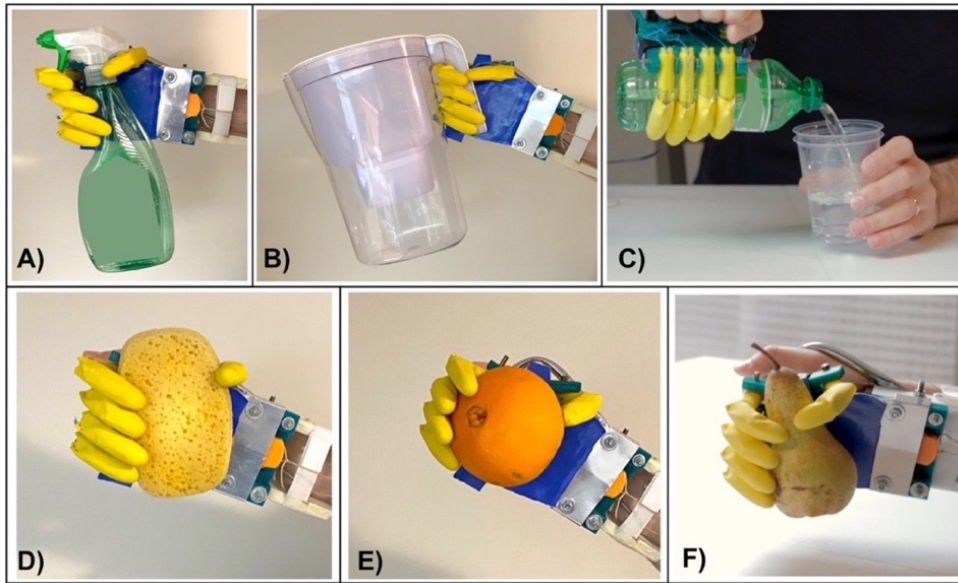
Figure 14. “Federica” hand tested on healthy subjects, while holding: ( A ) a spray cleaner; ( B ) a water tank; ( C ) a bottle; ( D ) a sponge; ( E ) an orange; ( F ) a